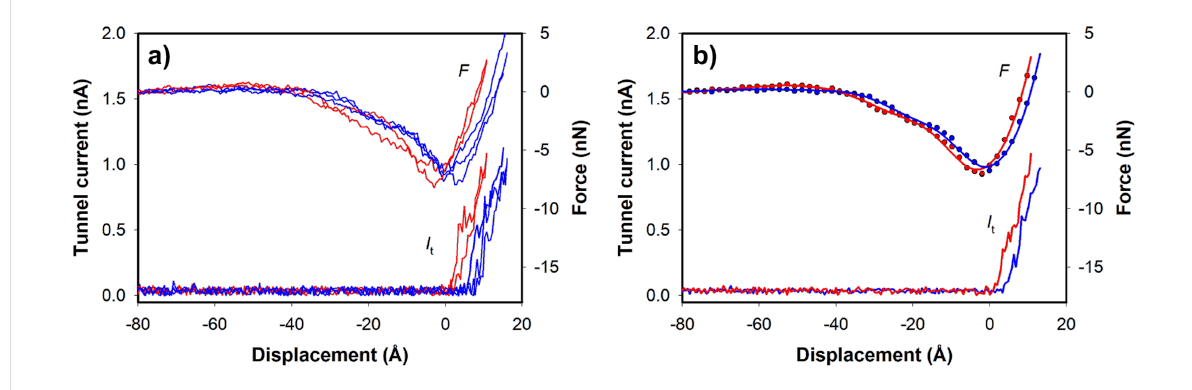
Figure 2: F – d spectroscopy; force ( F ) and tunnel current ( I t ) were measured as functions of the relative tip–sample displacement. a) Several curves on carbon (red) and hollow sites (blue) showing two distinct features. b) Average of curves on carbon (red) and hollow sites (blue). Solid lines in force curves are smoothened raw data (dotted). The curves at the hollow site are displaced by 2 Å to account for the shift in position of carbon and hollow sites. The curves were obtained using the W cantilever used in the imaging experiments, with k = 53 N/m; V sample = − 0.35